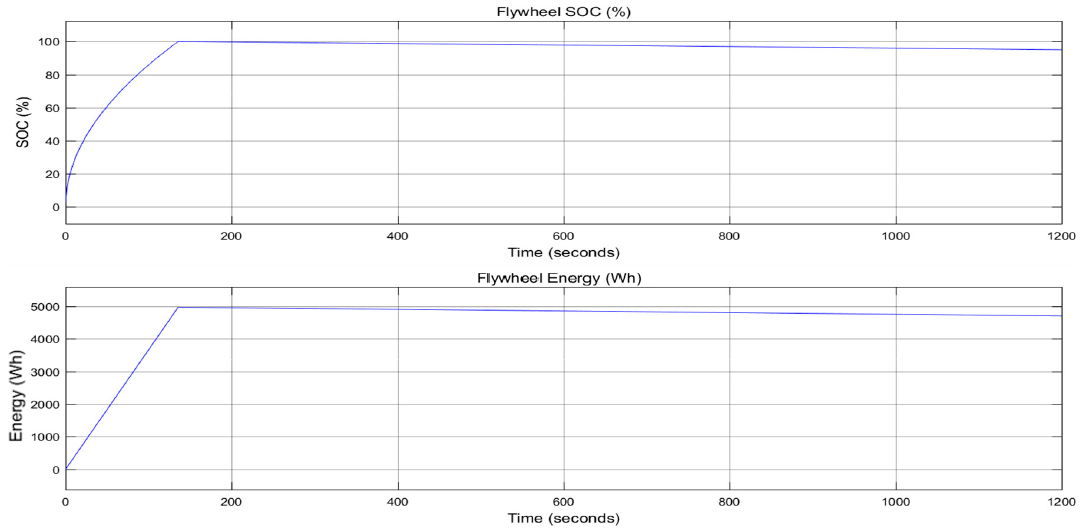
Figure 6. %SoC and energy stored by flywheel.